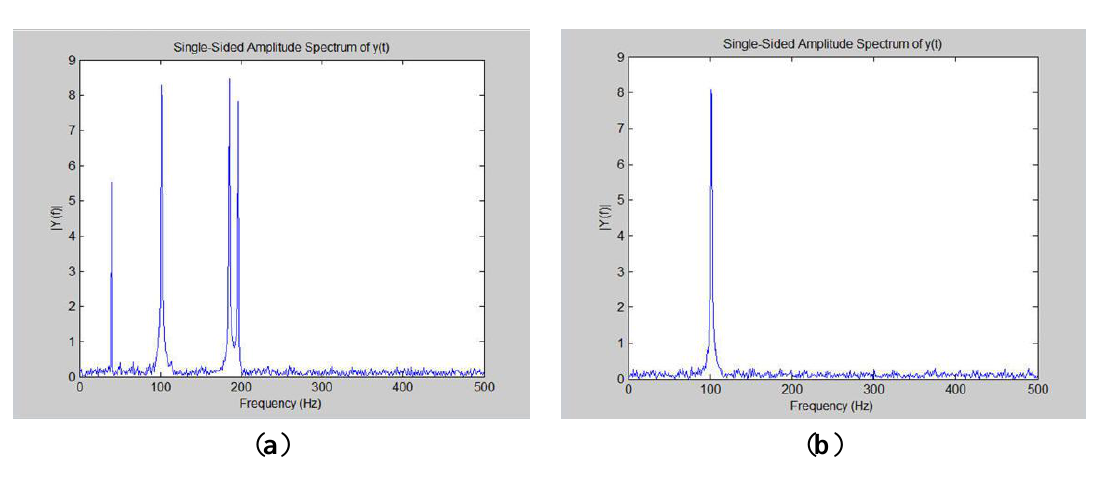
Figure 48. Using IFFT technology to restore the time